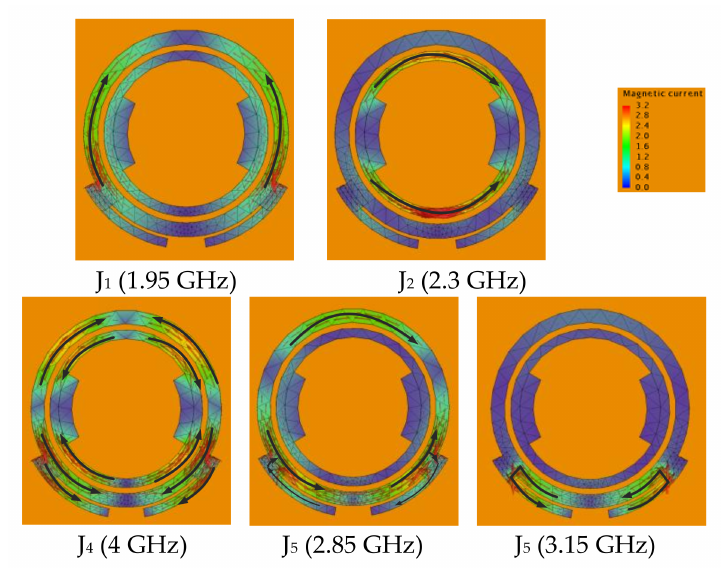
Figure 8. Magnetic eigencurrents of CMs.